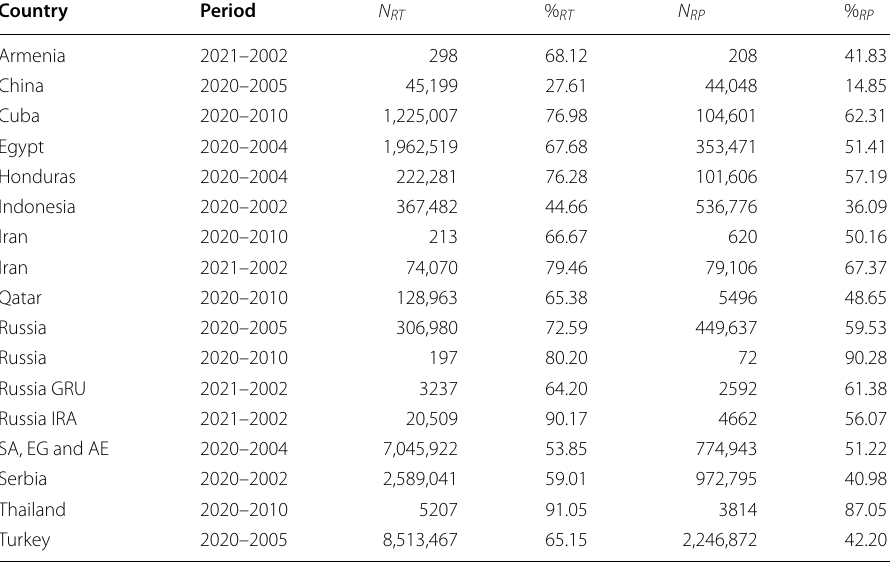
N RT ,% RT and N RP ,% RP denote the absolute number of messages and the percentages that could be downloaded for retweets and replies respectively